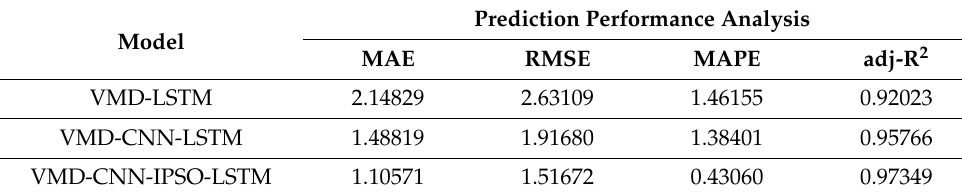
Table 5. Analysis of the prediction performance of each model.